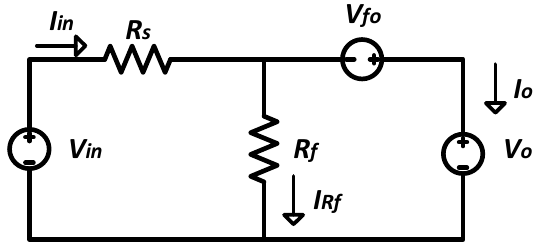
Figure 8. Equivalent circuit in low frequency averaged analysis.